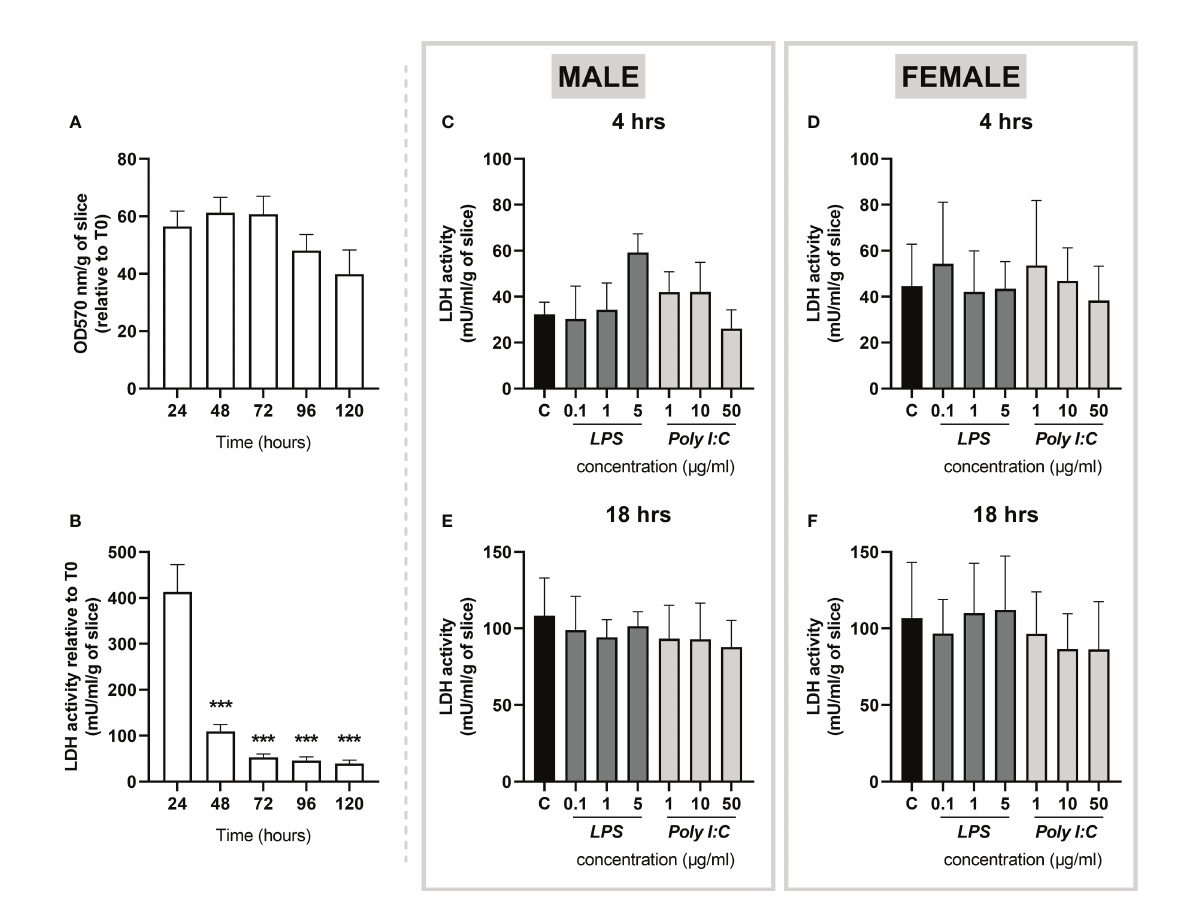
FIGURE 2 Viability and integrity of precision cut slices prepared from rat term placenta. (A) Viability of placenta slices was assessed by the MTT assay every 24 hours over a 120-hour period. (B) To evaluate tissue integrity, placenta slices were cultured for 120 hours under basal conditions, and LDH release was measured in the culture media every 24 hours. Similarly, LDH activity was evaluated upon LPS and Poly I:C treatment in male (C, E) and female (D, F) placental slices for 4 and 18 hours. All results were normalized to the tissue weight. Data represent the mean ± SEM; n ≥ 3. ***P <